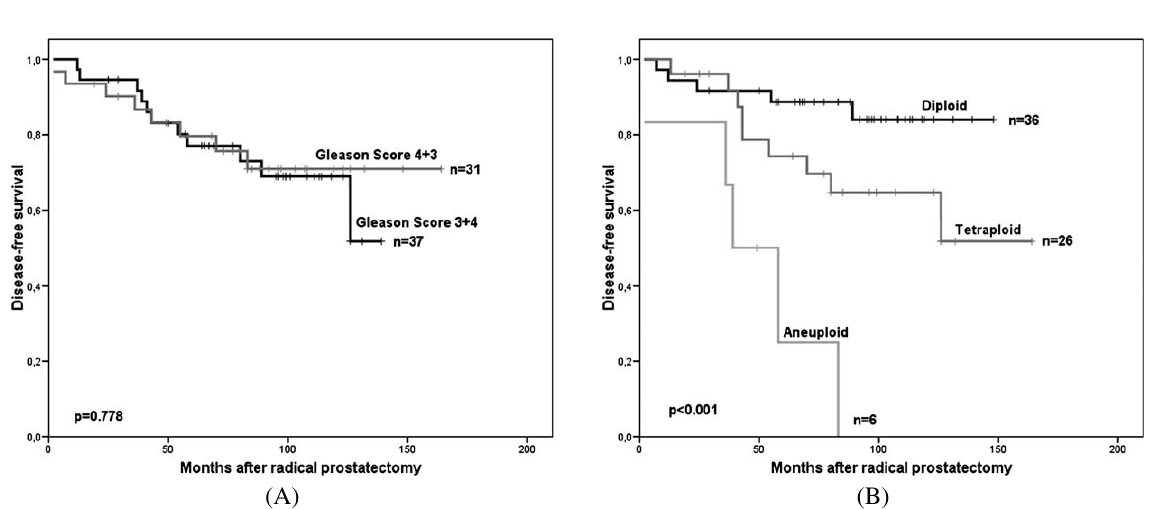
Fig. 2. Disease-free survival shown by Kaplan–Meier graphical analysis for Gleason score 7 patients according to (A) Gleason score and (B) DNA